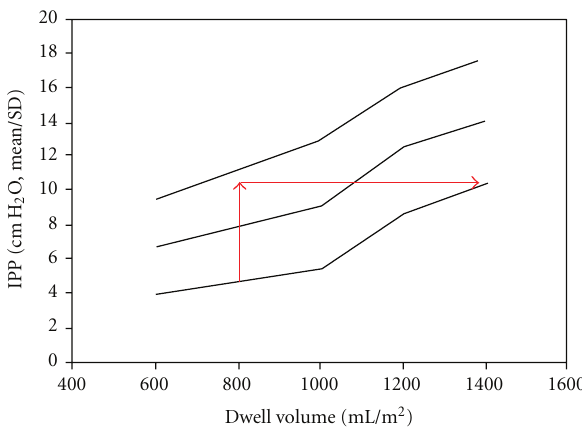
Figure 2: Intraperitoneal pressure (mean/SD) according to dwell volume in children on PD above two years of age [7, 26]. In infants IPP should be below 8–10cm, in children below 13-14 cm H 2 O. The red arrows give an example of how dwell volumes can be increased in patients with low